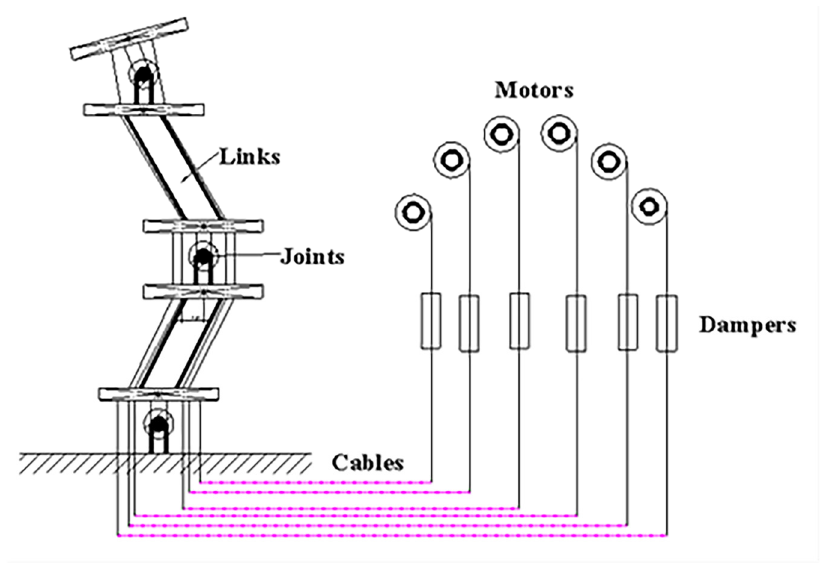
Figure 3. Illustration for the simplified planar 3-DOF cable-driven manipulator.